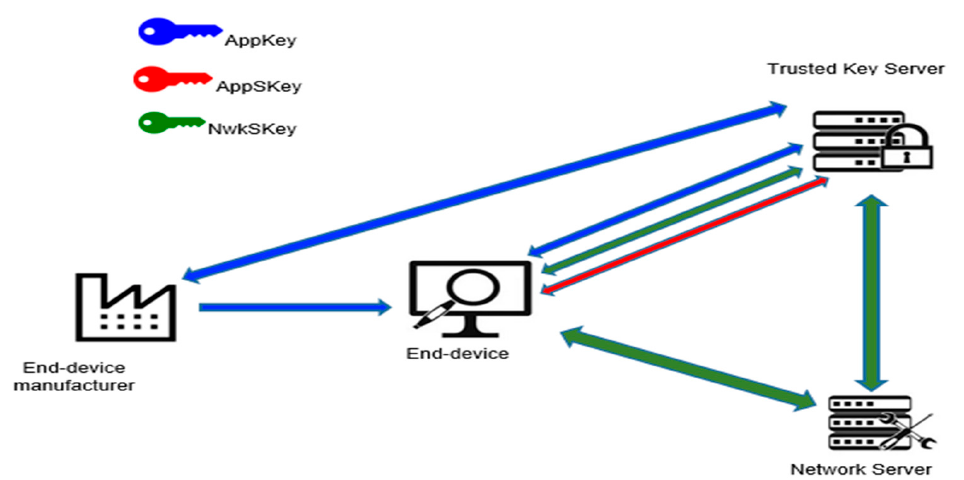
Figure 1. Key distribution architecture.